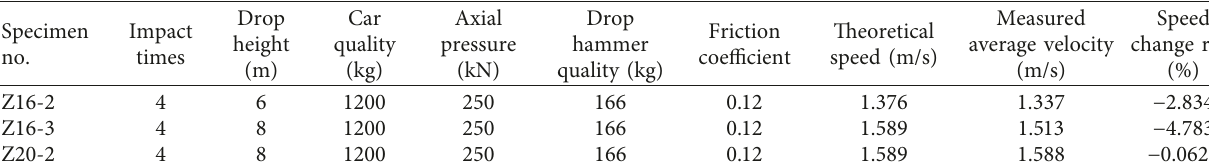
Table 4: Impact scheme